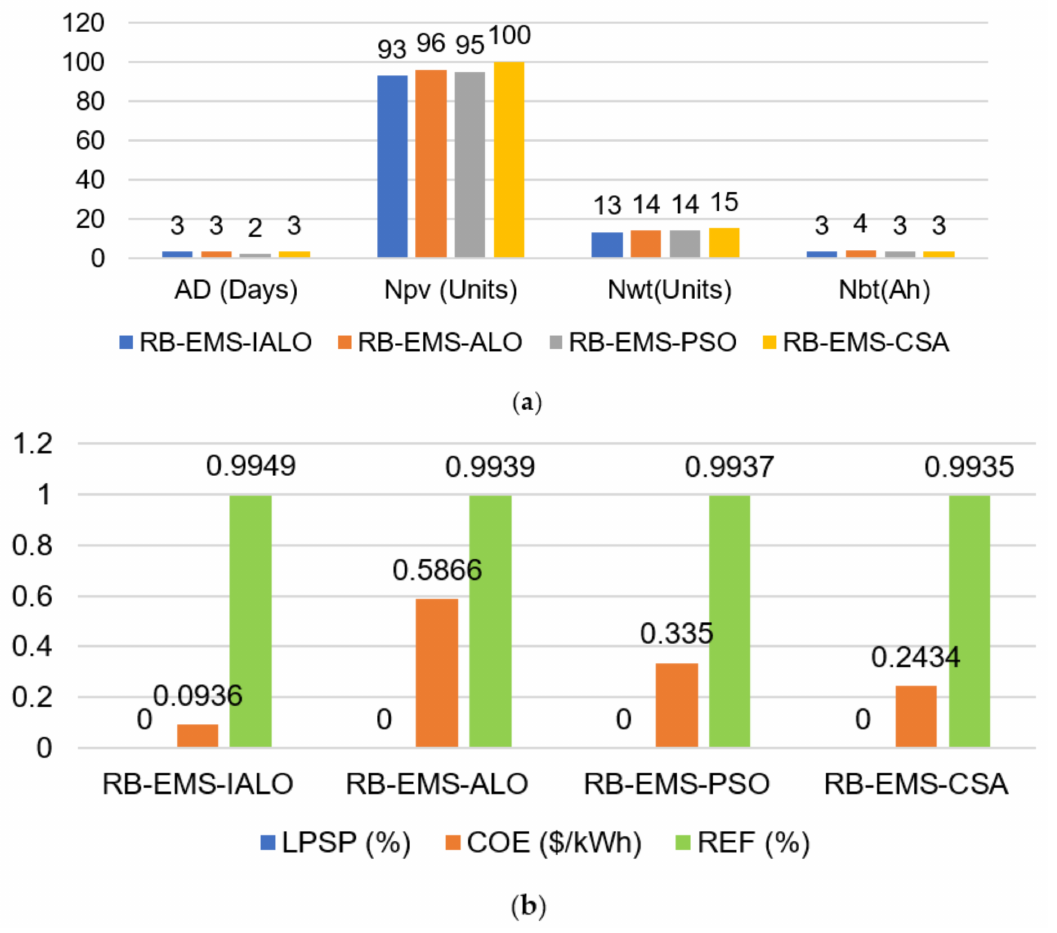
Figure 9. System configuration results: ( a ) Sizing and; ( b ) objective function COE and REF.